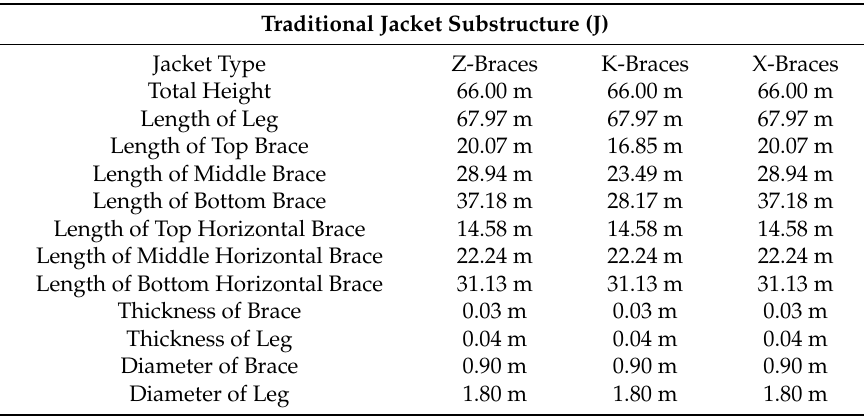
Figure A2. Side and top views of the X-braces (JX) structure.